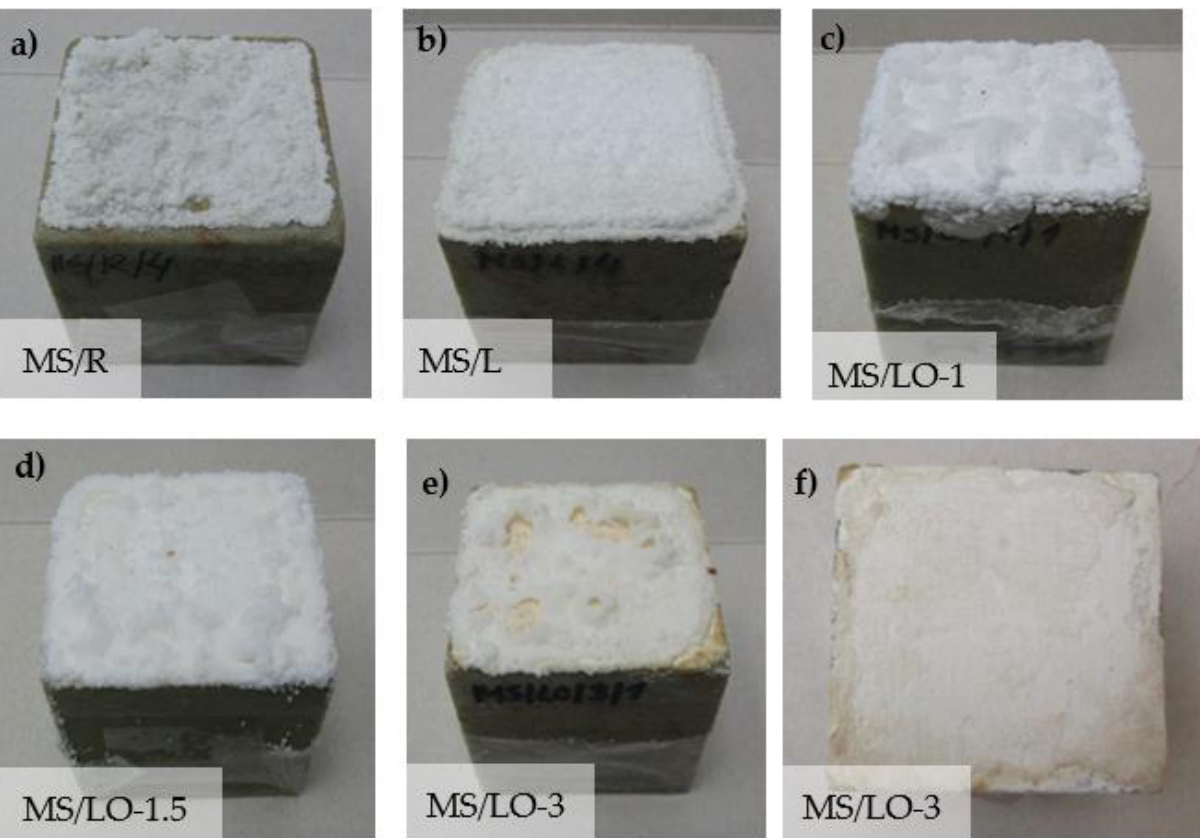
Figure 5. Mšené specimens at the end of the drying test after saturation with 1 wt.% of NaCl in respect to the specimens’ weight: ( a ) MS/R; ( b ) MS/L; ( c ) MS/LO-1; ( d ) MS/LO-1.5; ( e ) MS/LO-3; ( f ) MS/LO-3 after removing the salt efflorescence.